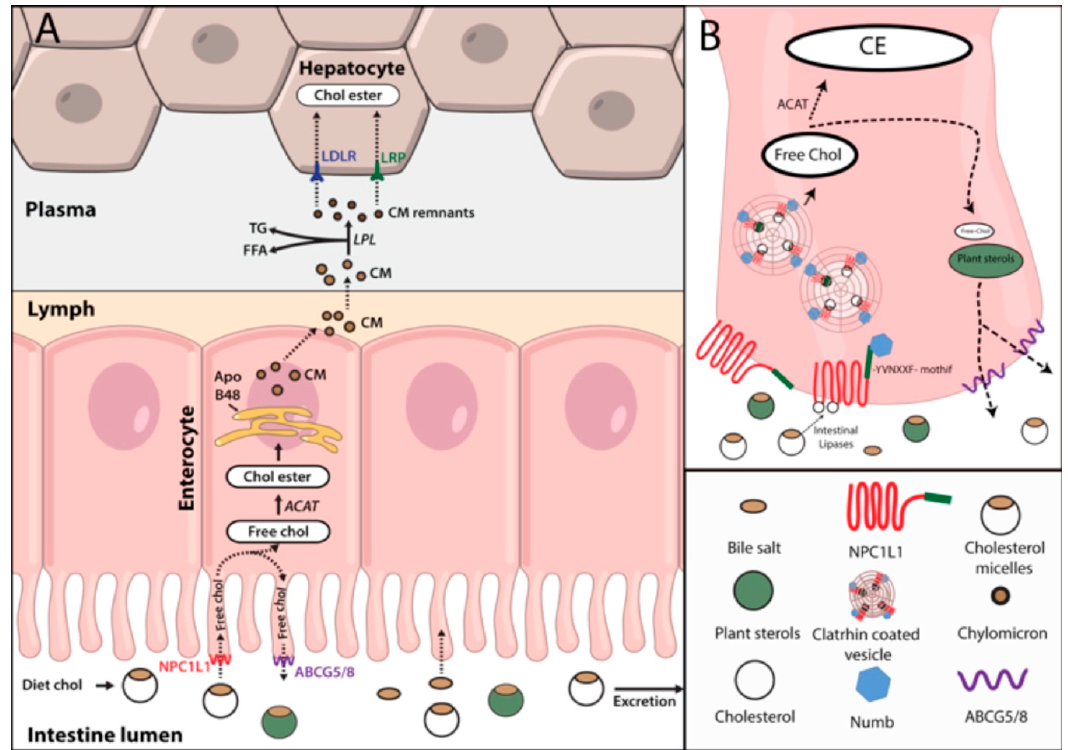
Figure 1. Dietary cholesterol absorption. ( A ) Diet cholesterol forms micelles in complex with bile acids and travel across the intestinal lumen where it is hydrolyzed and taken up by Niemann-Pick C1-like 1 in the enterocyte membrane. Internalized cholesterol can either be transported back to the intestinal lumen through ABCG5/8 along with plant sterols or esterified by Acyl-CoA acyl-transferase. Esterified cholesterol within other lipids is incorporated into chylomicrons and secreted to the lymph. Once in the lymph they are drained to the plasma where by lipoprotein lipases activity lose their triglycerides and become in chylomicron remnants that are finally taken up by the liver by low density lipoprotein receptor or LDLR related proteins. ( B ) Free cholesterol binds NPC1L1 and promotes its conformational change. This conformational change allows the binding of Numb adapter protein to YVNXXF motif and promotes its internalization in clathrin coated pits. Abbreviations: NPC1L1: Niemann-Pick C1-like 1; ACAT: Acyl-CoA acyl-transferase; Chol ester: Esterified cholesterol; CM: Chylomicrons; LPL: lipoprotein lipases; TG: Triglycerides; FFA: Free fatty acids; LDLR: low density lipoprotein receptor; LRPs: LDLR related